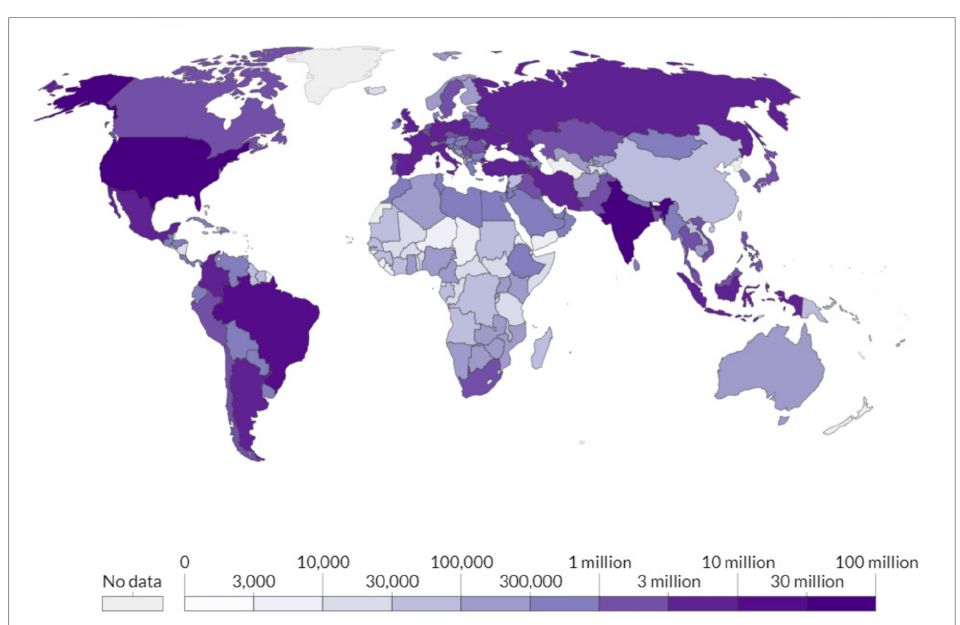
Figure 1. Total COVID-19 cases (2 December 2021). OurWorldInData.org. Available online: https: //ourworldindata.org/coronavirus (accessed on 2 December